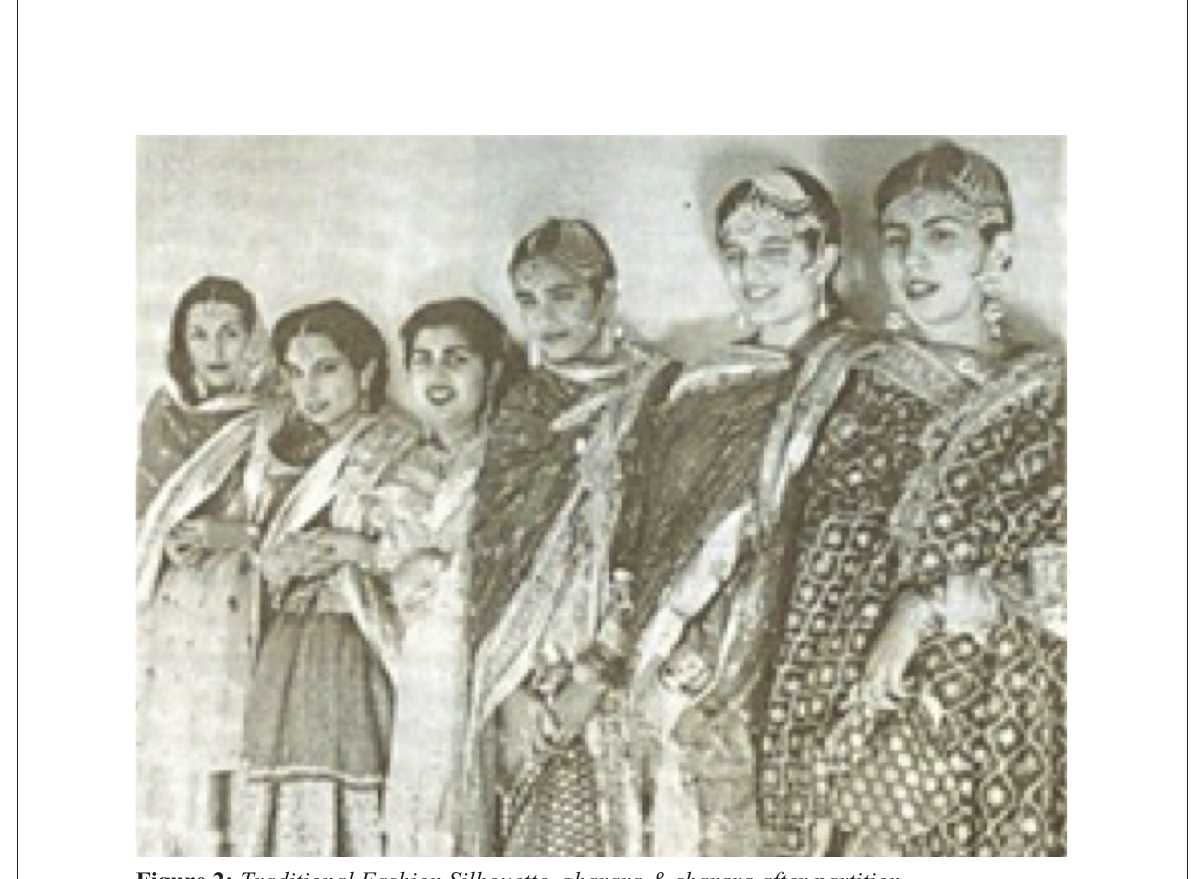
Figure 2: Traditional Fashion Silhouette, gharara & sharara after